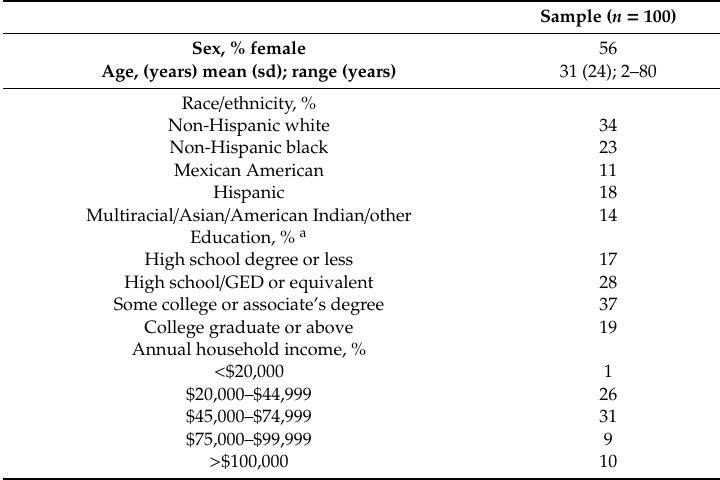
Table 3. Baseline demographic characteristics, 100 respondents with day 1 dietary recalls randomly selected from the National Health and Examination Survey